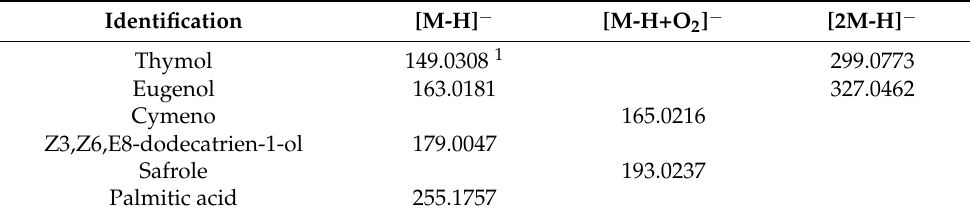
Figure 2. DART mass spectra of essential oil of P. auritum with a heated argon gas temperature of 300 °C in negative ion mode. The major molecular ions m/z are represented as adducts [M-H] − , [M-H+O 2 ] − , or [2M-H] − . ( a ) Intensity vs. m/z. ( b ) Relative intensity vs. m/z. The mass to charge ratio (m/z) of each anion is represented by the value of the peaks. The letter M in blue indicates the molecular weight of the metabolite. Table 2. Main metabolite adducts generated in aerial part essential oil of P. auritum by DART-MS and proposed chemical formulas.